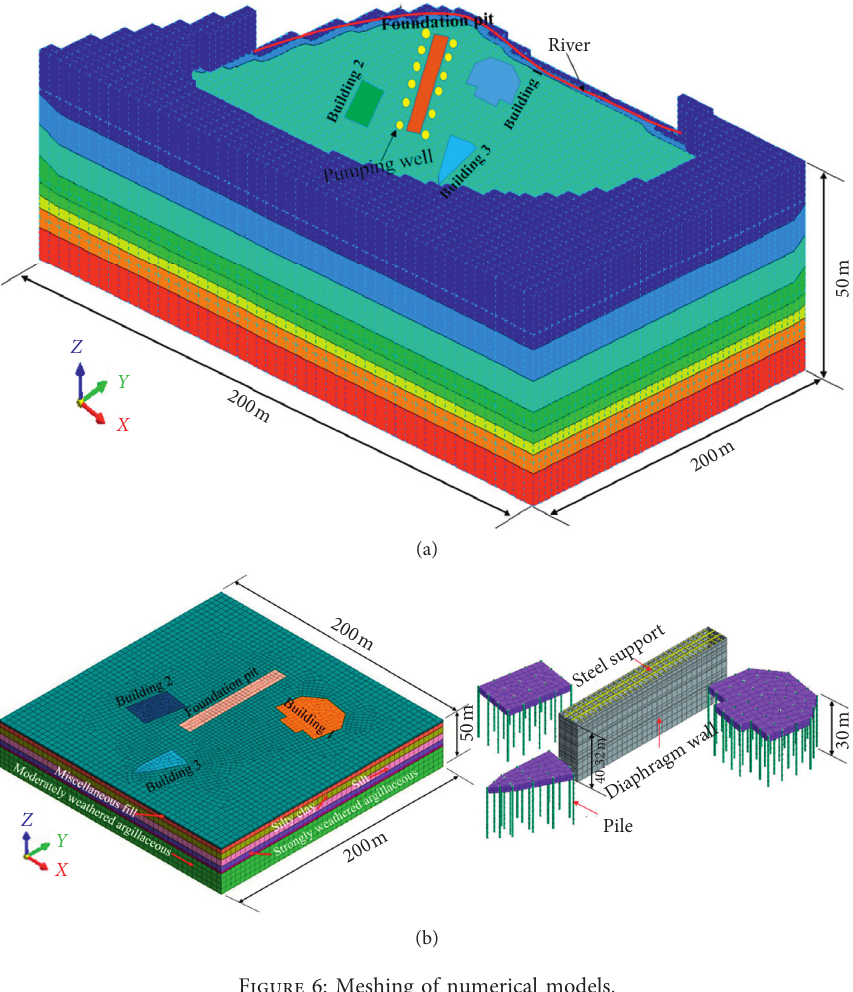
Figure 6: Meshing of numerical models.